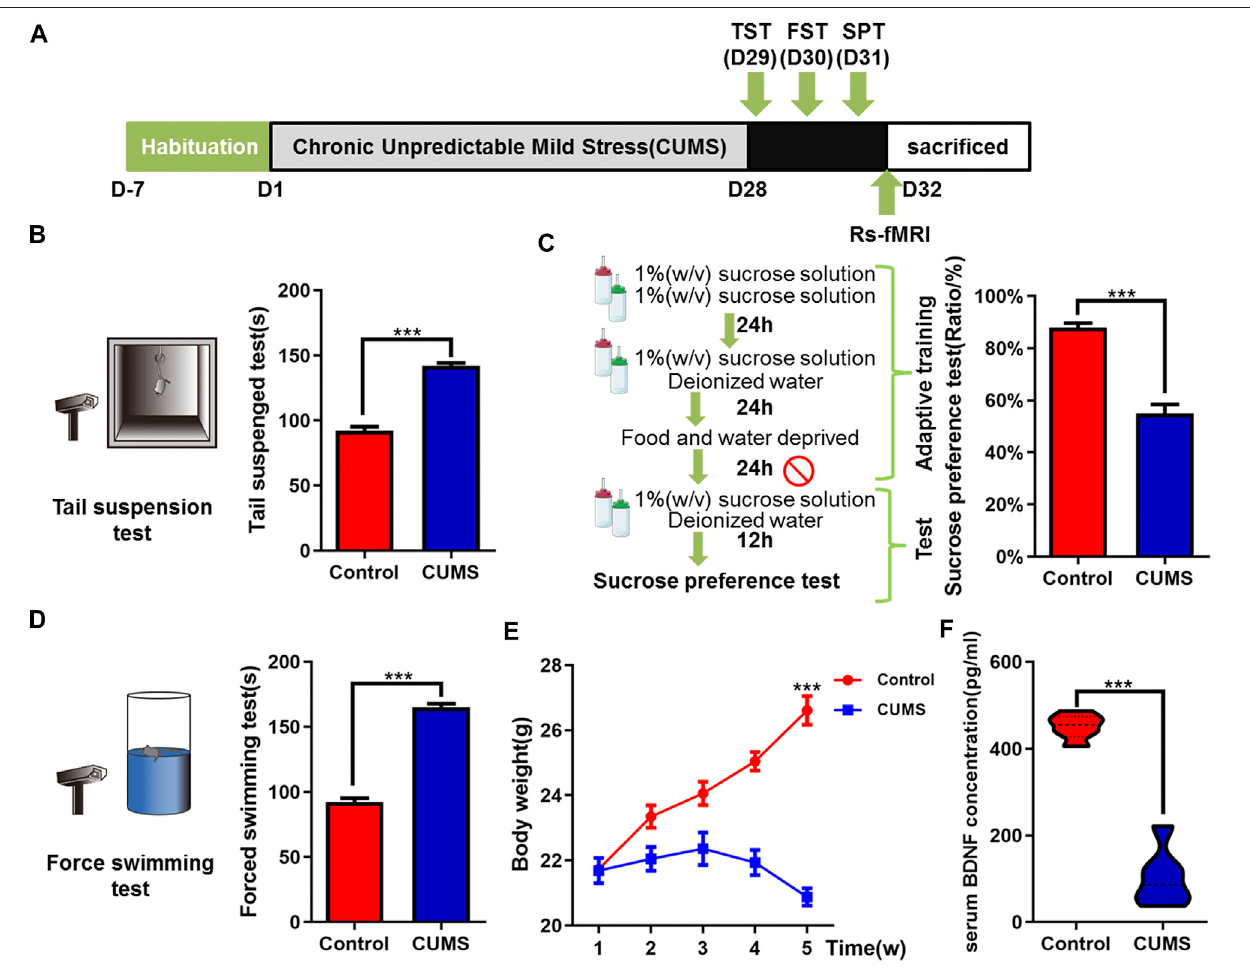
FIGURE 1 | Effects of chronic unpredictable mild stress on depressive-like behaviors of mice. (A) Schematic overview of CUMS experimental approach and time line. (B – D) Micebehavioraltests. (B) Tailsuspensiontest(TST); (C) sucrosepreferencetest(SPT);and (D) forceswimmingtest(FST). (E) Curveofweightchangeinmice. (F) Effect of CUMS on the expression of BDNF in serum of mice. The data are presented as mean ± SEM. *** p < 0.001. CUMS group vs. Control group.